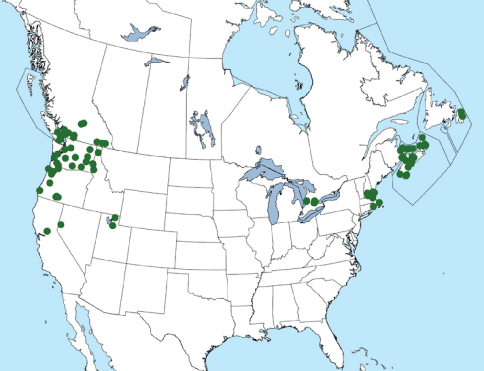
Distribution of Xantholinus linearis in North America. Distribution incorporates previous records from the literature (Smetana 1982, 1988, 1990; Sikes 2003, Majka and Klimaszewski 2008a).